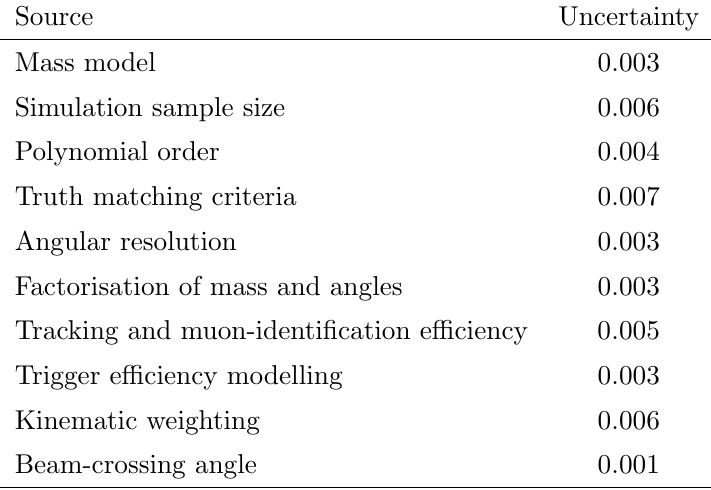
Table 4 . Systematic uncertainties on the angular moments. The largest value amongst the moments is given for each source. The total systematic uncertainty varies from 0.002 to 0.010, depending on the moment considered. The sources are described in the